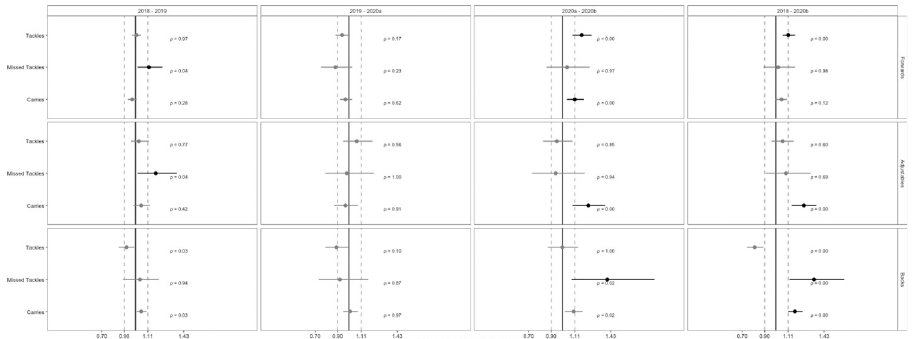
Fig 2. Standardised rate ratio ( ± 90% confidence interval) differences in match events between SL seasons 2018 to 2020 b .